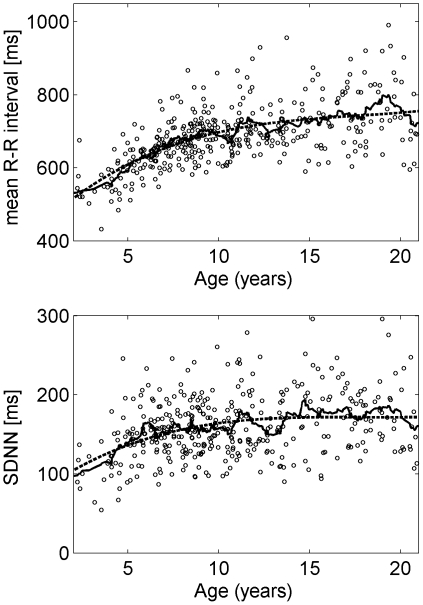
Course of the mean R-R interval and its accompanying standard deviation (SDNN) as basic time domain measures during childhood and adolescence.The circles represent 24 h averages. Solid and dashed lines show moving average and the fitted polynomial model of order 3, respectively.